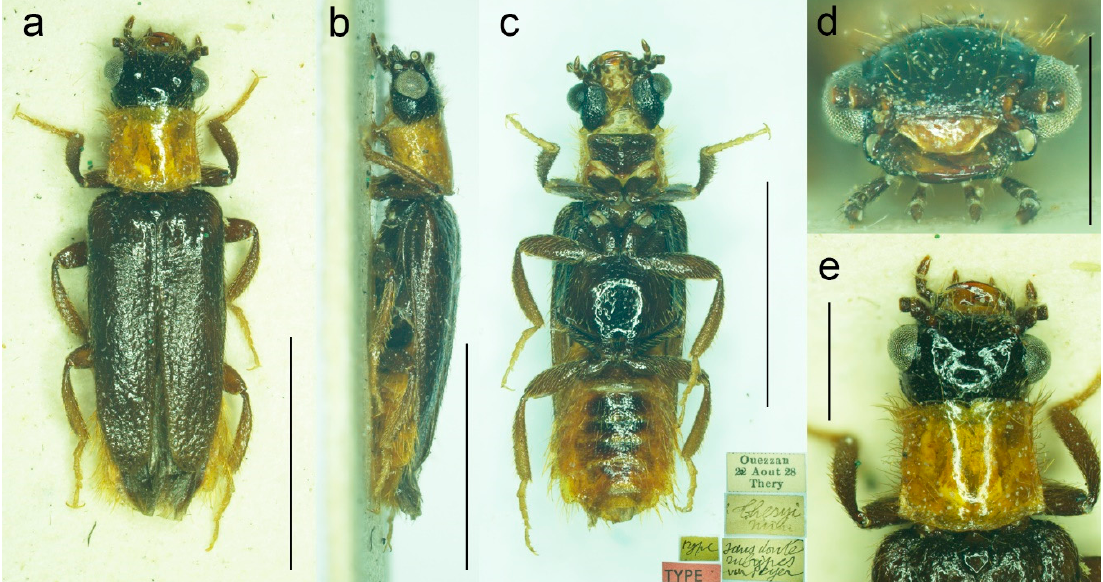
Figure 22. Malacogaster theryi Pic, 1949, male holotype. ( a ) Habitus, dorsal view; ( b ) habitus, lateral view; ( c ) habitus, ventral view; ( d ) head, frontal view; ( e ) pronotum, dorsal view. Scale bars = ( a – c ) 3.0 mm; ( d , e ) 1.0 mm.